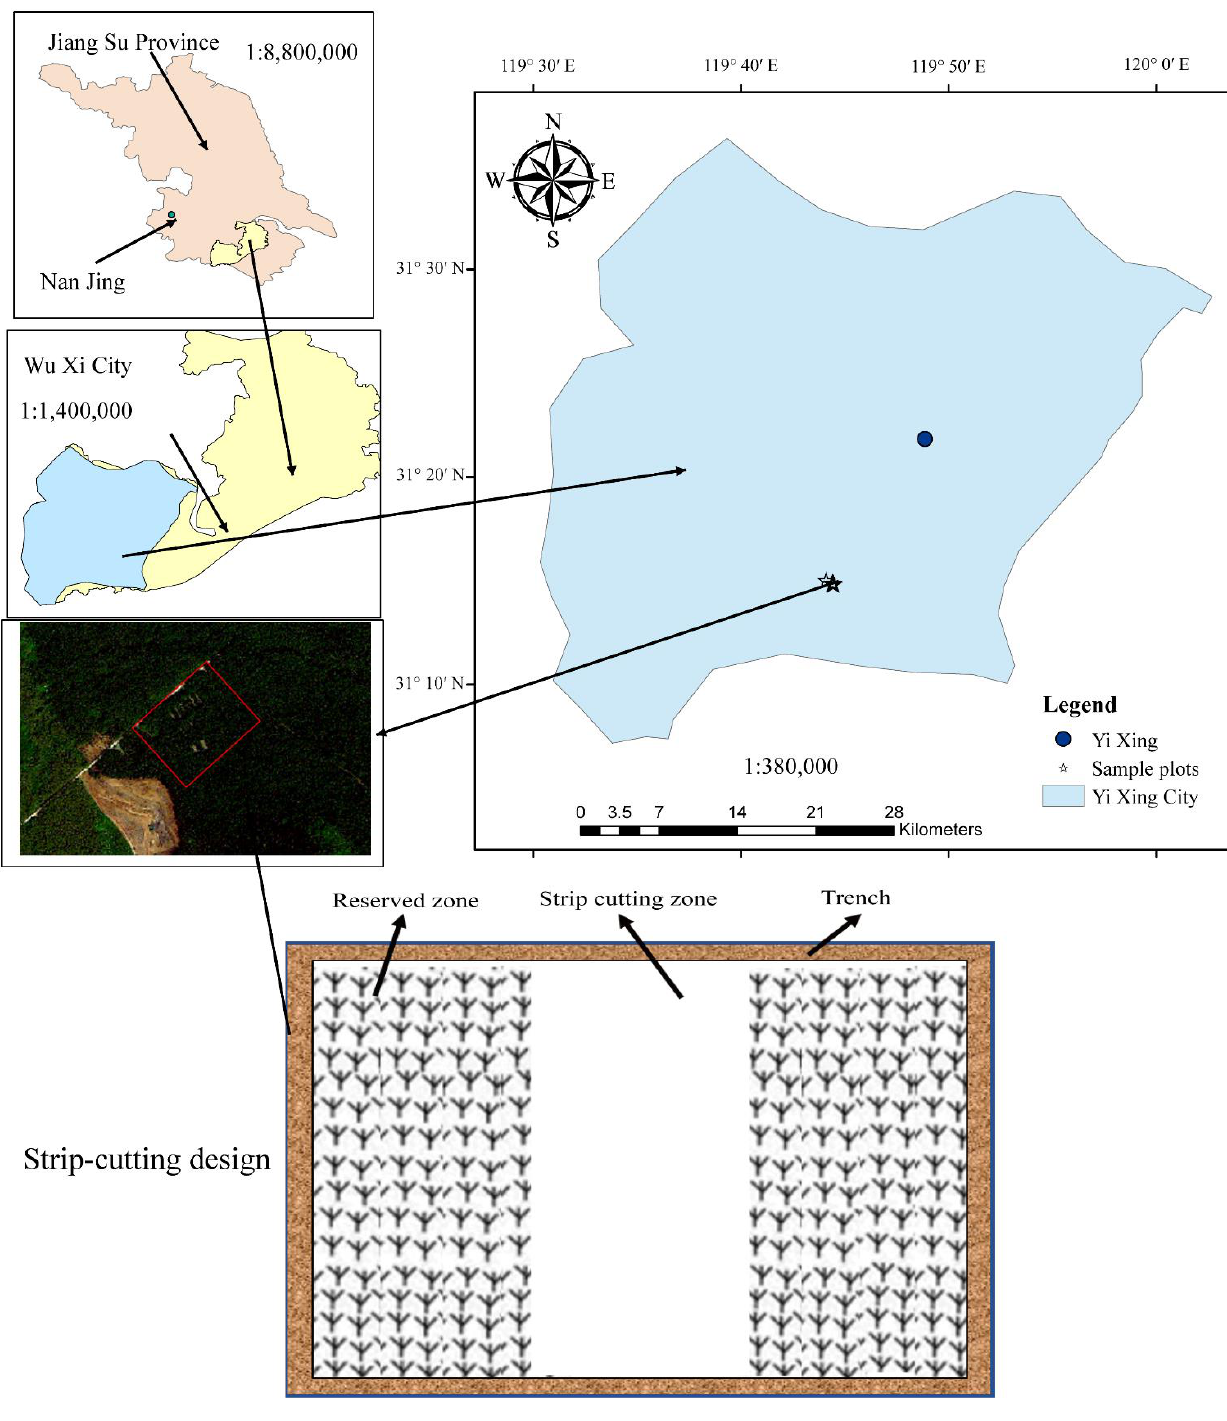
Figure 1. Study area showing the sample plot locations and strip-cutting